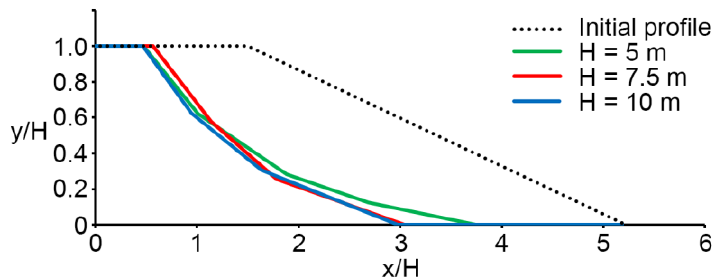
Figure 9. Location of the slip surface in dimensionless coordinates, for the case with α = 15°, φ’ = 35°, ∆ u = 40 kPa, and di ff erent values of H.